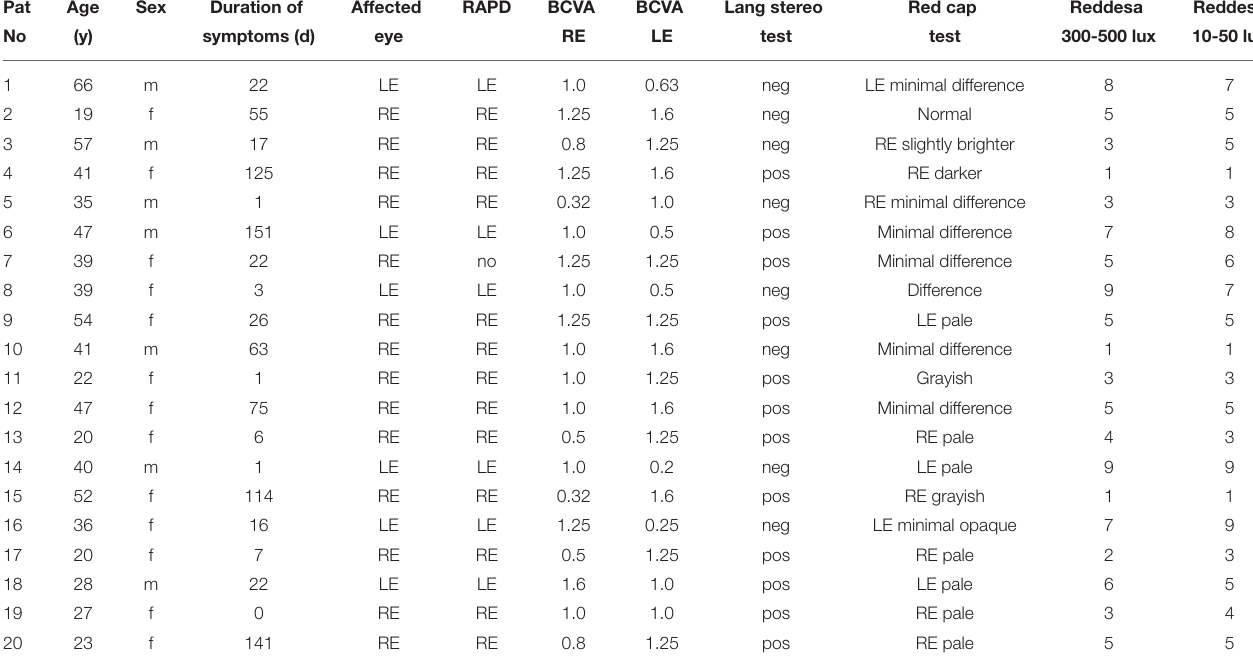
TABLE 1 | Clinical characteristics of patients with optic neuritis ( N = 20). Pat